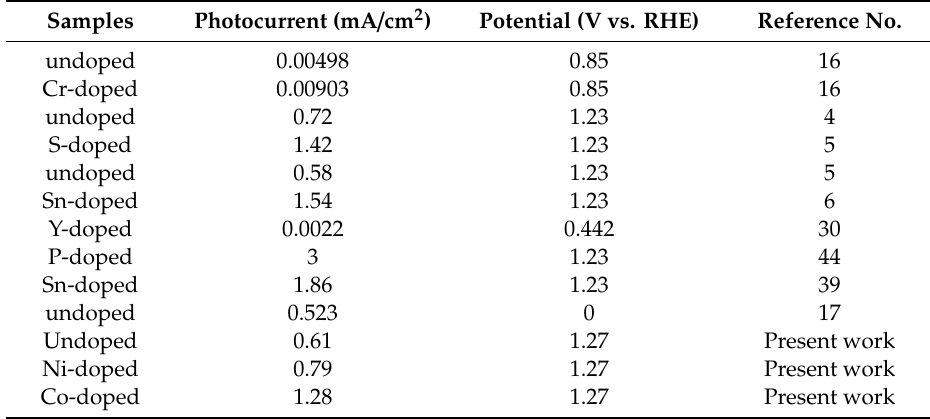
Table 1. Photocurrent densities of doped and undoped α-Fe 2 O 3 at a certain potential versus reversible hydrogen electrode (RHE) reported in the literature.